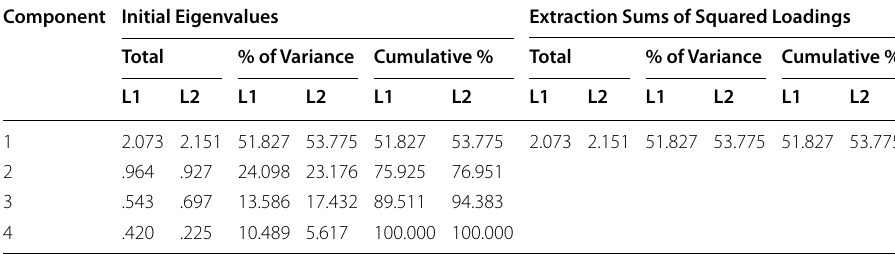
Table 14 Total Variance Explained for L1 and L2 Use in Assessment